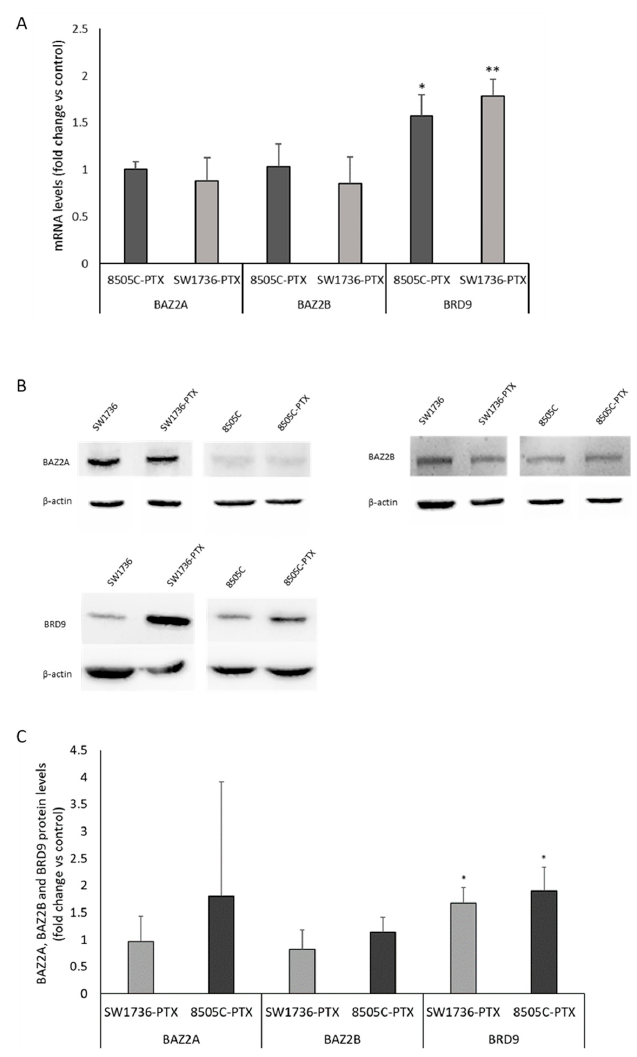
Figure 1. BAZ2A , BAZ2B, and BRD9 gene expression and protein levels. ( A ) Relative expression levels of BAZ2A , BAZ2B , and BRD9 mRNA in 8505C-PTX and SW1739-PTX. For each cell line, mRNA expression in the paclitaxel-sensitive parental cell line was set at 1. ( B ) Western blot analysis of BAZ2A, BAZ2B and BRD9 in paclitaxel-sensitive anaplastic thyroid cancer cell lines (SW1736 and 8505C), SW1736-PTX and 8505C-PTX cells. ( C ) Densitometric analysis of BAZ2A, BAZ2B and BRD9 protein levels in these four cell lines. For each cell line, the results were normalized against β -actin levels and expressed in arbitrary unit. Protein expression in the paclitaxel-sensitive parental cell line was set at 1 and data are expressed as fold change respect to control. n = 3, * p < 0.05, ** p <